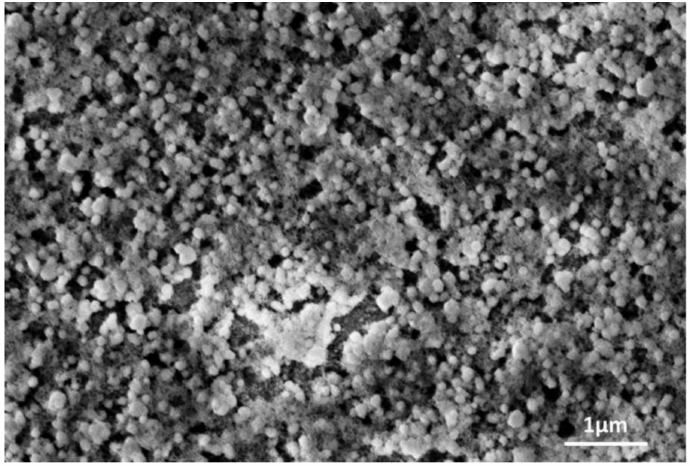
Figure 5. Micrograph of nanostructured SiO 2 inorganic